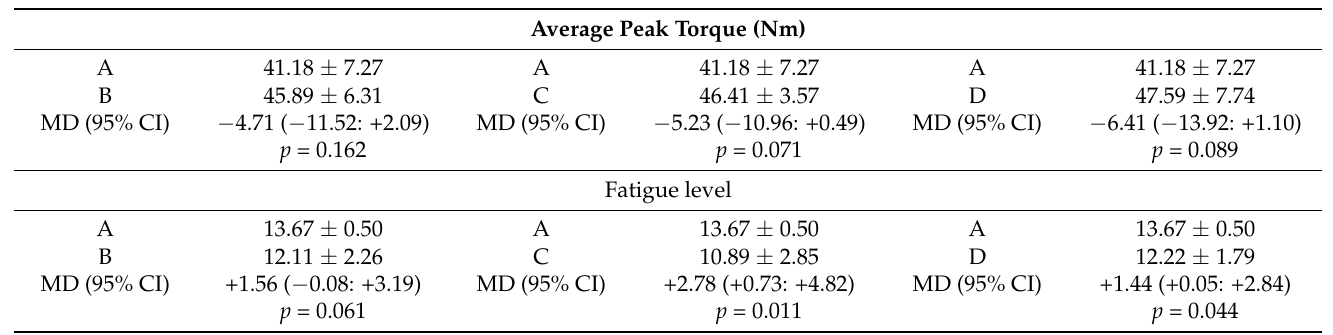
Table 6. Comparison of average peak torque and fatigue level after treatment between the experi- mental group and the control